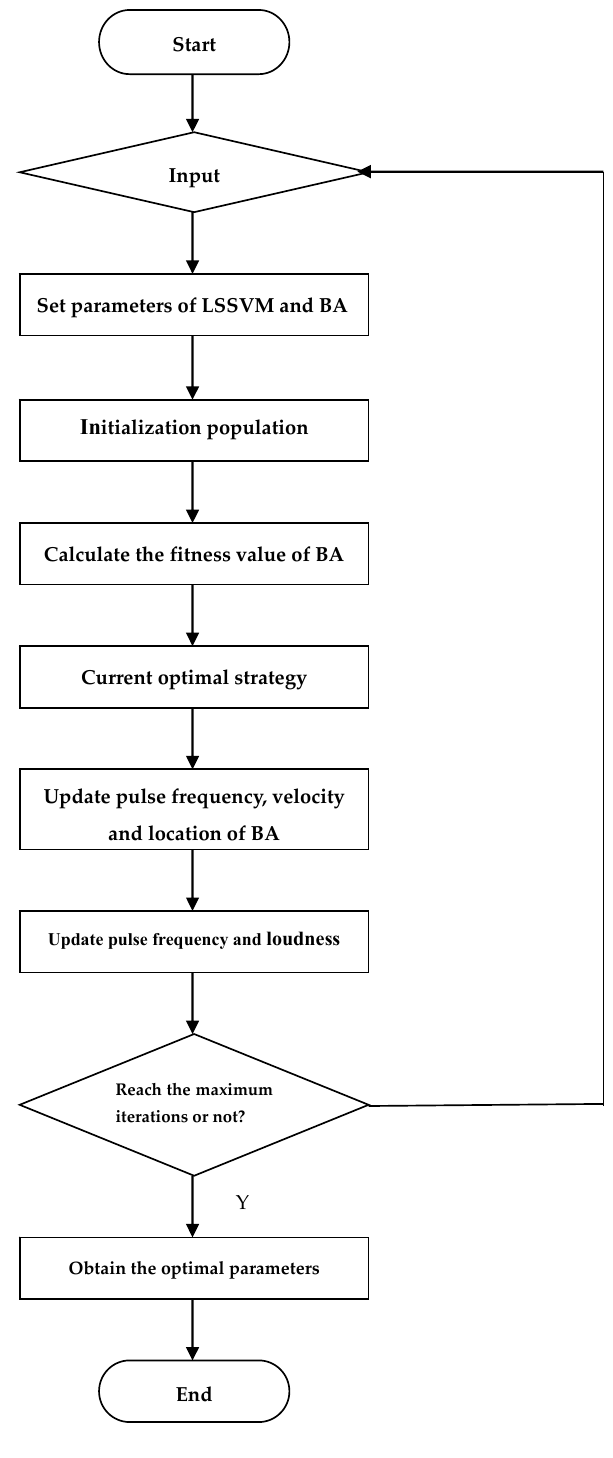
Figure 2. The flow chart of BA ‐ LSSVM.